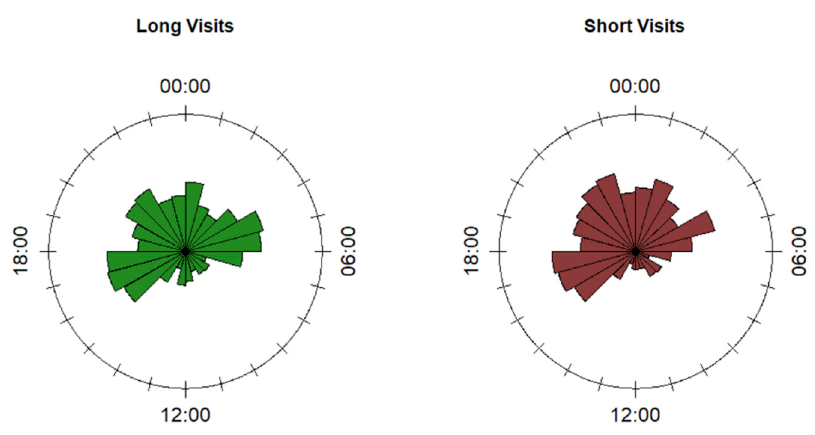
Figure 4. Rose diagrams displaying the circular distribution of the modes of the timestamps of the visits to feeding sites by marked roe deer, grouped by day and feeding site, separated into long and short visits. Hours are shown in UTC.